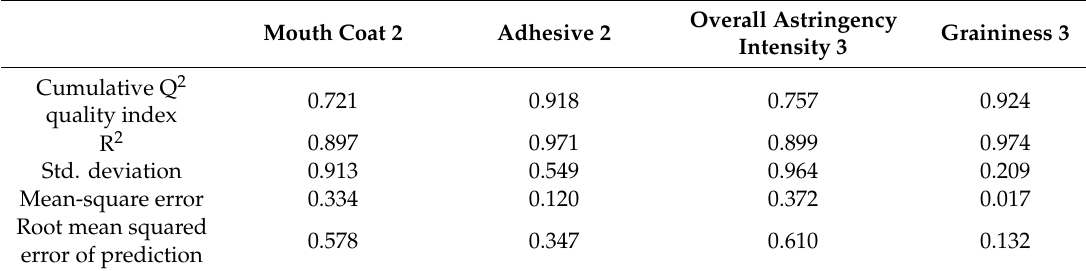
Table 6. Fit statistics of the partial least squares regression (two components) analysis between the discriminated astringency attributes (Y) and significantly different chemical parameters (X).